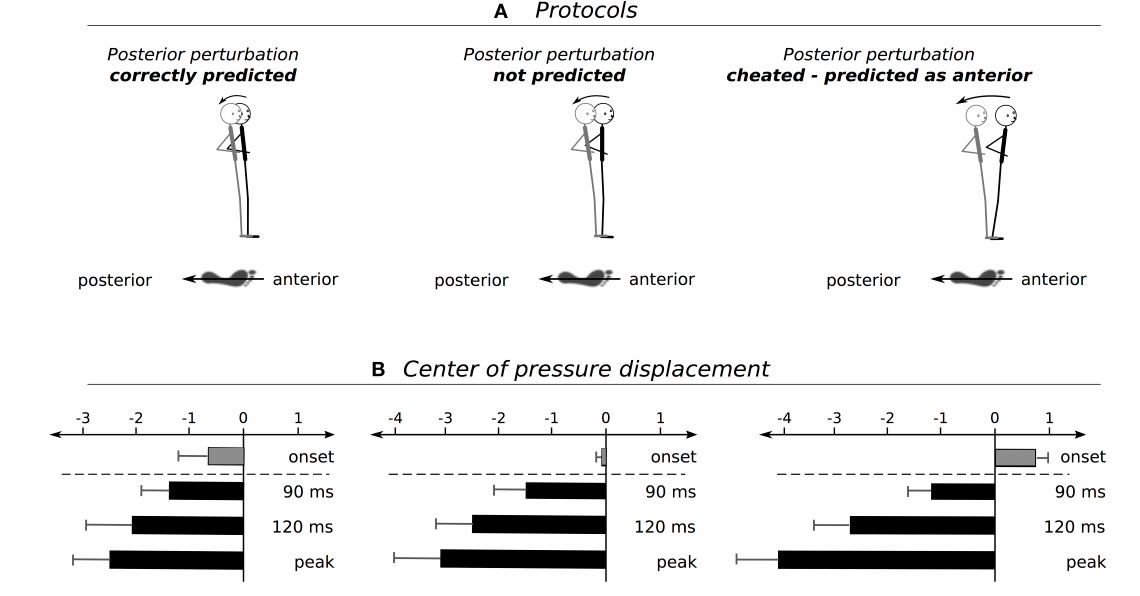
cables and recorded with 1 kHz. The cables were carefully taped to the